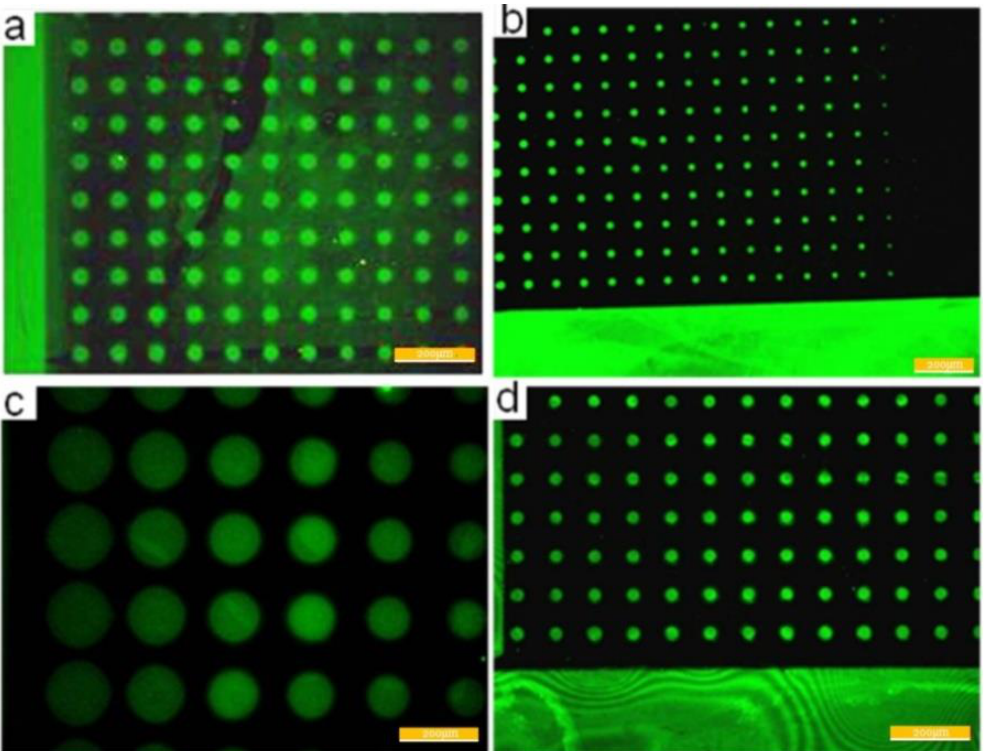
Figure 8. Streptavidin patterning results. The largest diameter is 72 µ m and the smallest diameter is 8.4 µ m. It can be seen that the Streptavidin patterning results is very good. ( a ) Patterns with big diameters. ( b ) Patterns with smallest diameters. ( c ) Patterns with largest diameters. ( d ) Patterns with middle diameters.